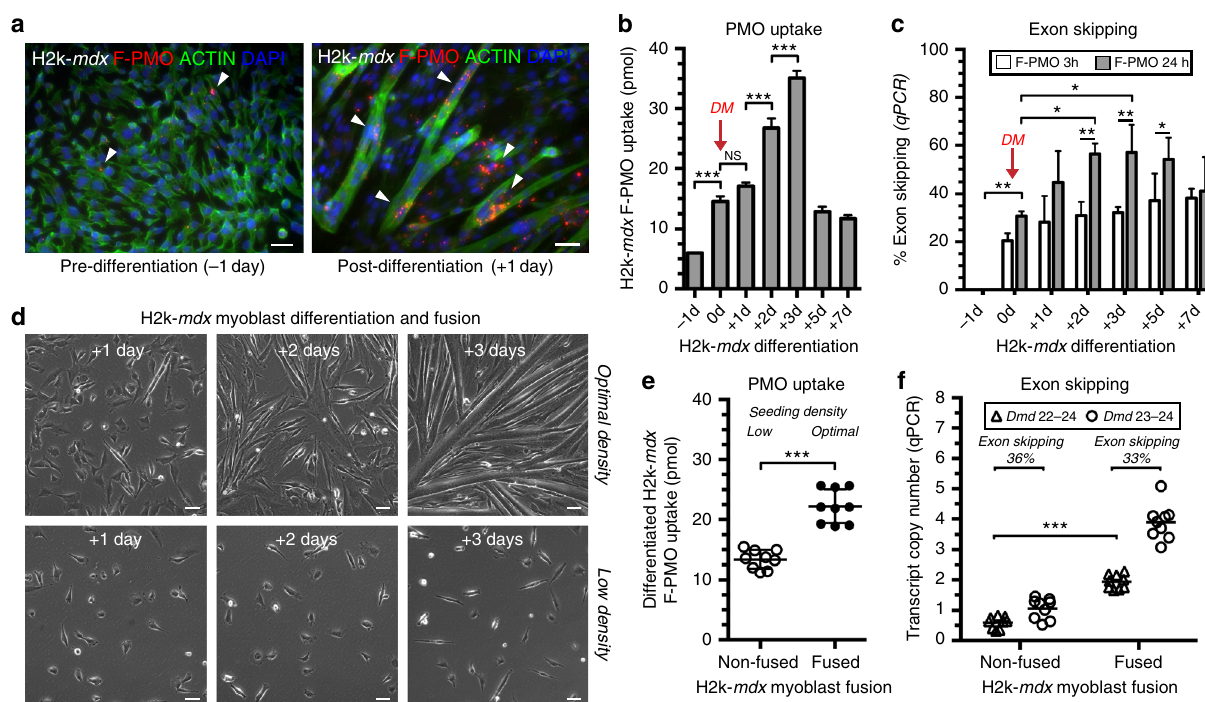
Fig. 8 In vitro assessment of PMO uptake during myoblast differentiation and fusion. a F-PMO uptake in H2k- mdx myoblasts and fusing myotubes in vitro after a 24h treatment with 100 μ M F-PMO. F-PMO ( red ), actin ( green ), DAPI ( blue ). b Quanti fi ed F-PMO uptake (pmol) in H2k- mdx myoblasts at the designated time points pre-differentiation and post-differentiation after treatment with 100 μ M F-PMO. c Exon skipping quanti fi ed by RT-qPCR as relative level of skipped vs. unskipped Dmd transcript 24h following a 3 or 24h F-PMO treatment (100 μ M). Data represented as mean with SD. DM denotes change to differentiation media. d DIC imaging of H2k- mdx myoblasts at time points after onset of differentiation when seeded at optimal density to promote ef fi cient myoblast fusion, or low density to inhibit myoblast fusion. e Quanti fi ed F-PMO uptake (pmol) in H2k- mdx cells treated with F-PMO (100 μ M, 24h) 2 days post-differentiation when maintained at optimal or low density. f Dmd mRNA transcript copy number quanti fi ed by RT-qPCR for skipped and unskipped transcripts 24h after F-PMO treatment (100 μ M, 24h) in response to myoblast differentiation and fusion. Data represented as bar graph or scatter plot with SD. Statistical analysis performed by one-way ANOVA ( b , c ) or Mann – Whitney nonparametric test ( e , f ), *** p < 0.001, ** p < 0.01, * p < 0.05. Scale bars represent 50 μ